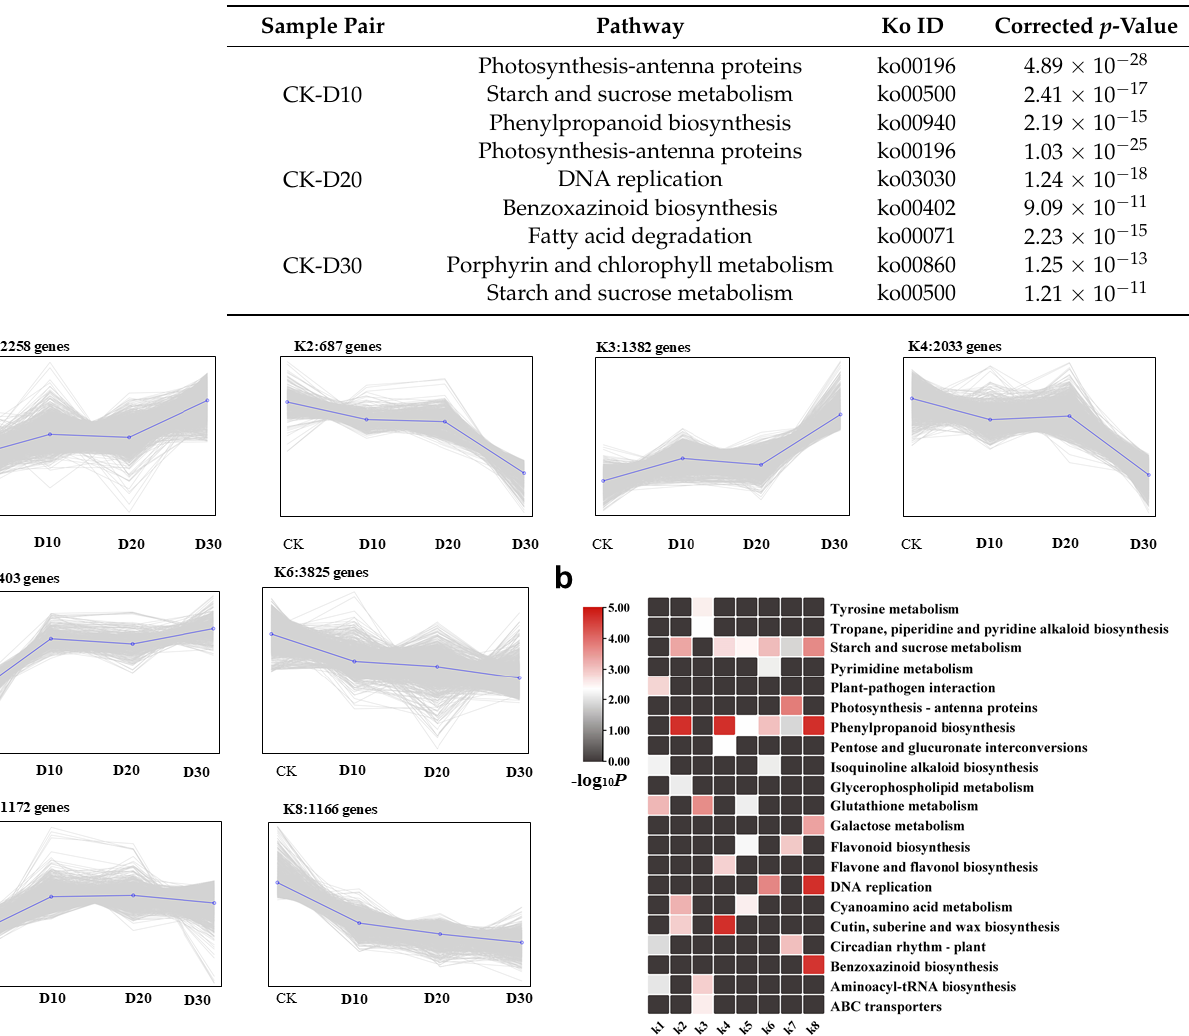
Table 2. Major pathways that the DEGs involved in.